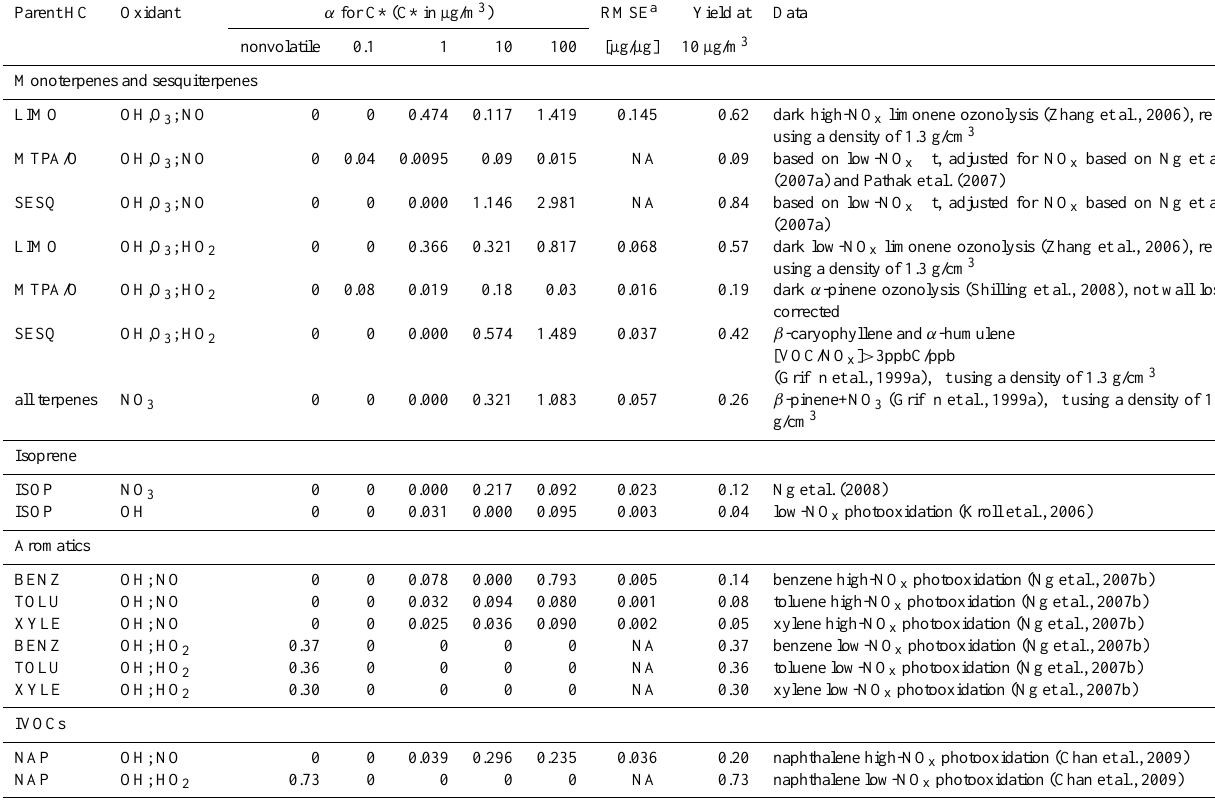
Table 1. SOA Yield Parameterizations at 298K. Parent